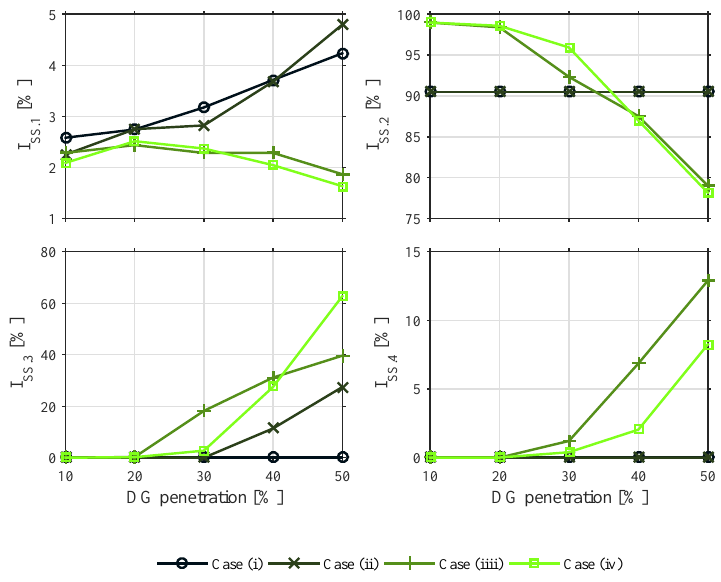
Figure 9. Trend of diverse SS related metrics with respect to DG penetration